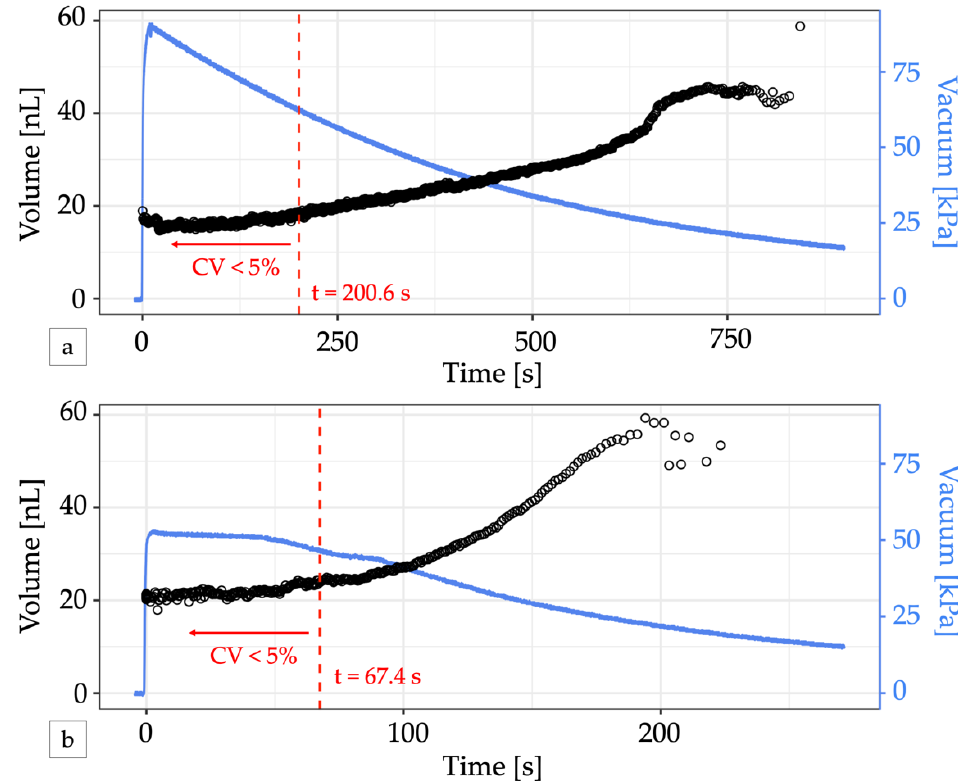
Figure 4. Electricity-free droplet generation. ( a ) A 60 mL locking syringe supplies enough vacuum pressure (blue line) to generate droplets (black circles) for over 10 min. The change in volume is minimal for vacuum pressures greater than 50 kPa. For the first 200.6 s (dashed red line), 465 droplets were produced with a CV < 5% and a mean volume of 16.52 nL. ( b ) Adding a vacuum regulator to the syringe output can provide a stable vacuum pressure for a short time but produced fewer uniform-sized droplets. In the first 67.4 s, 158 droplets with a mean volume of 21.77 nL were produced with a CV < 5% (dashed red line). In both graphs, the first two droplets generated were omitted from volume calculations to account for system stabilization.